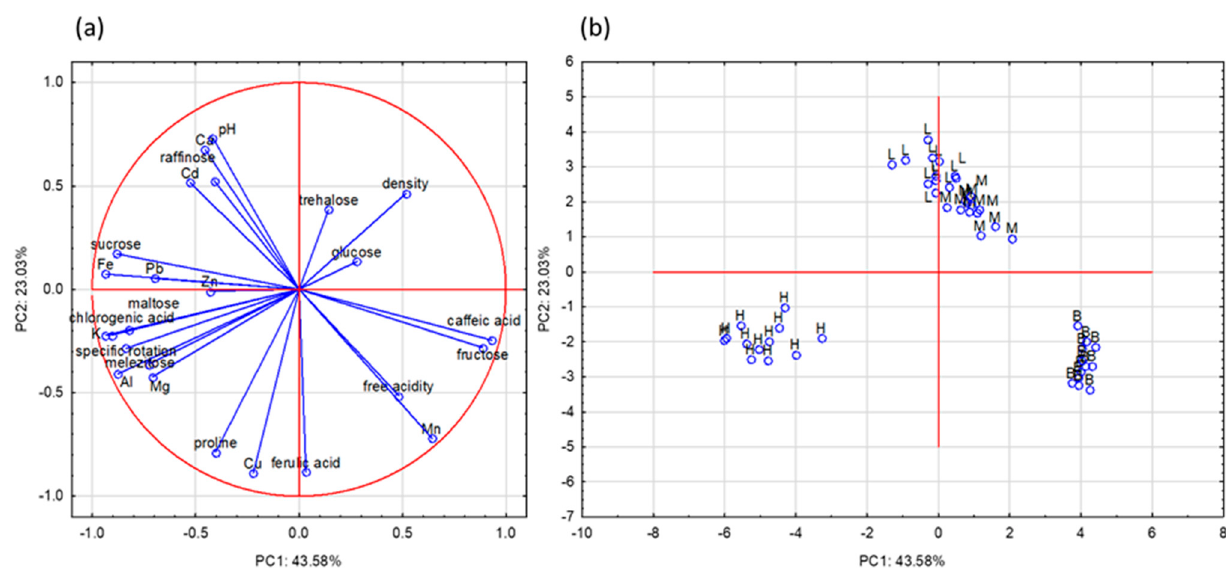
Figure 1. Principal component analysis results: ( a ) projection of chosen variables and ( b ) honey samples as a function of the